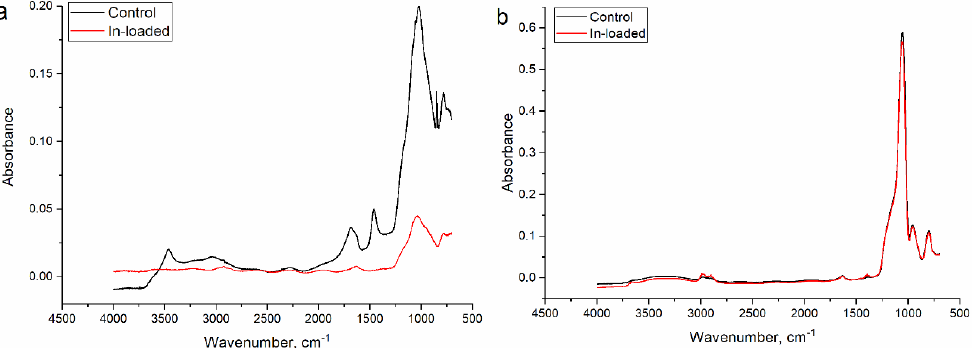
Figure 3. FTIR spectra of studies sorbents ( a ) silica SBA-15 and ( b ) titanosilicate ETS-10.